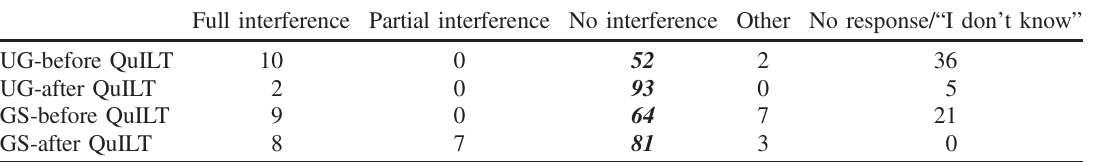
TABLE X. Percentages of undergraduate (UG) and graduate students (GS) with different answers on Q4 (partial interference, no interference, full interference, other, and no response/ “ I don ’ t know ” ). Bold italic indicates correct responses.